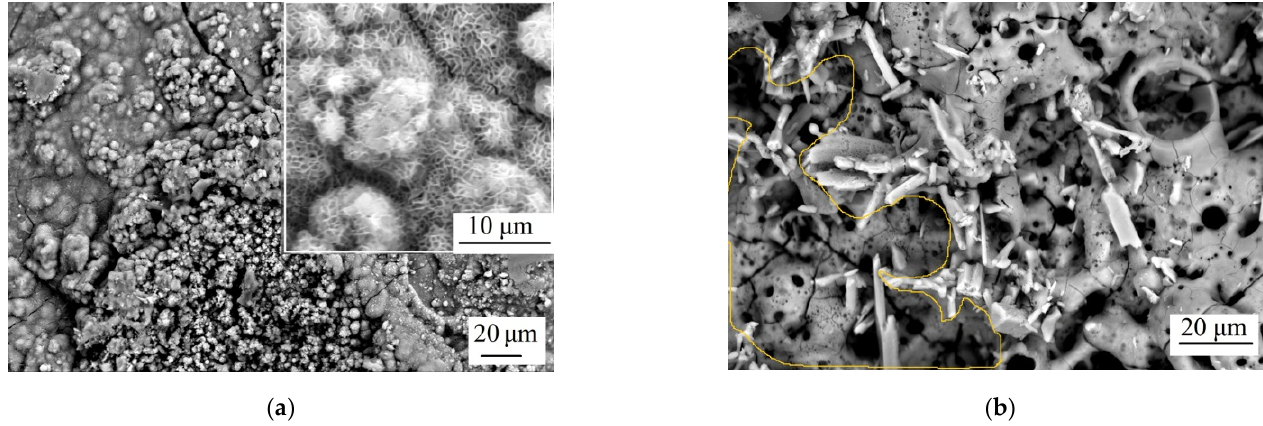
Figure 11. SEM images of the surface of the Mg0.8Ca alloy ( a ) and of the W-coating ( b ) after 16-day dissolution in 0.9% NaCl.